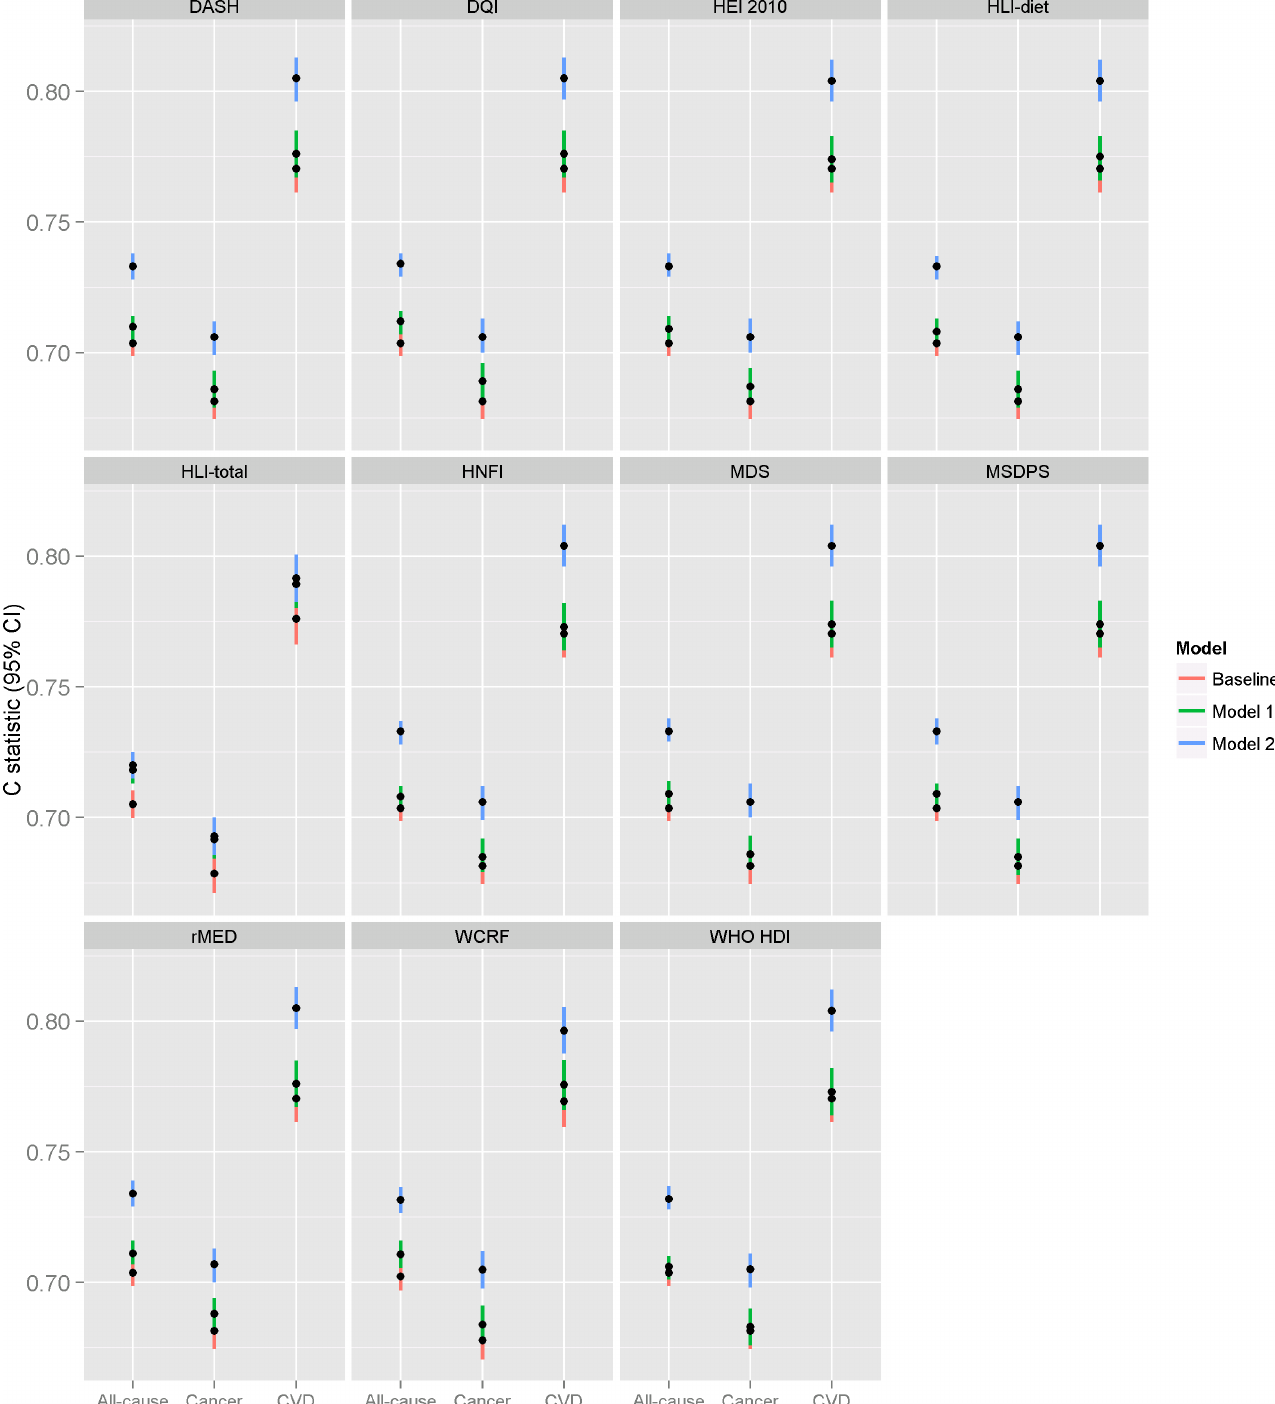
PLOS ONE | DOI:10.1371/journal.pone.0159025 July 13, 2016 11 /